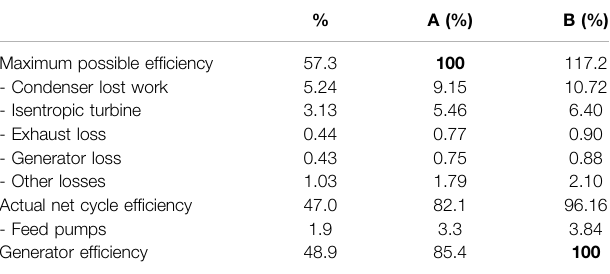
TABLE 4 | Steam turbine/cycle ef fi ciency breakdown (column A: reference to maximum possible ef fi ciency, column B: reference to generator (gross) ef fi ciency.